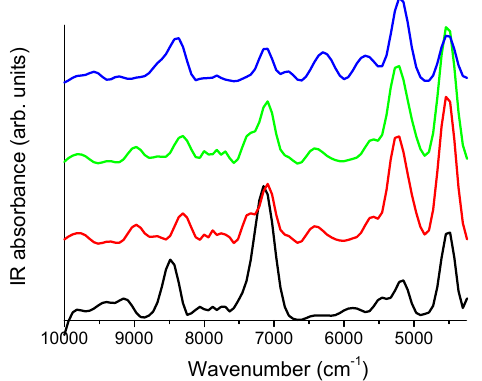
Figure 8. Near-infrared (NIR) spectra, in the 10,000 − 4250 cm − 1 spectral range, of IDE (black line), HP- β -CD (red line), IDE + HP- β -CD 1:2 physical mixture (green line), and IDE/HP- β -CD 1:2 inclusion complex (blue line).